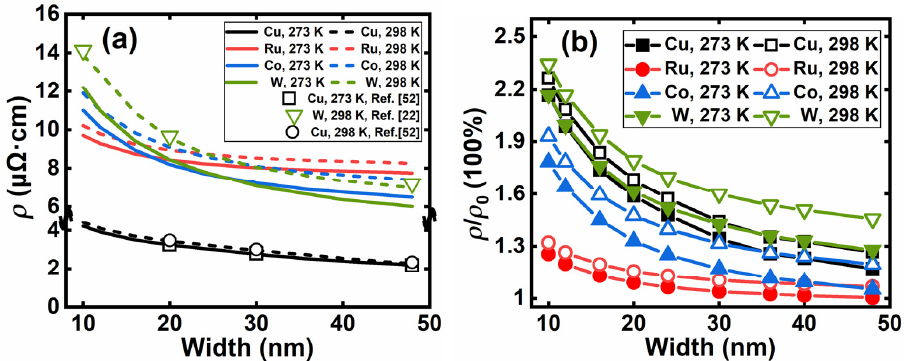
Figure 7. ( a ) Comparison of simulated resistivity and measured data at 273 and 298 K; ( b ) the ratio of the nanoscale interconnects resistivity ρ to bulk resistivity ρ 0 as width scaling down at 273 and 298 K.